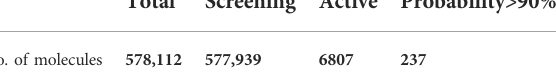
TABLE 4 Test dataset for Machine Learning